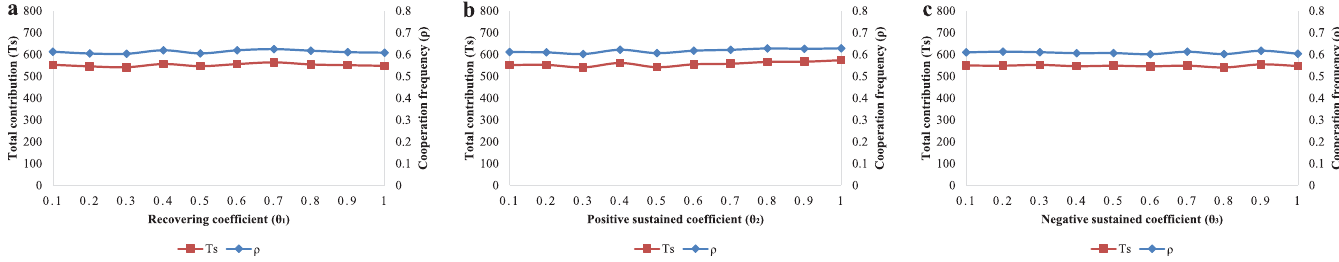
Fig 8. The equilibrium results of total contributions Ts and cooperation frequency ρ for different values of θ 1 , θ 2 and θ 3 . (a)The equilibrium results of total contributions and cooperation frequency for different values of recovering coefficient θ 1 varying from 0.1 to 1 with an interval of 0.1. (b) The equilibrium results of total contributions and cooperation frequency for different values of positive sustained coefficient θ 2 varying from 0.1 to 1 with an interval of 0.1. (c)The equilibrium results of total contributions and cooperation frequency for different values of negative sustained coefficient θ 3 varying from 0.1 to 1 with an interval of 0.1.